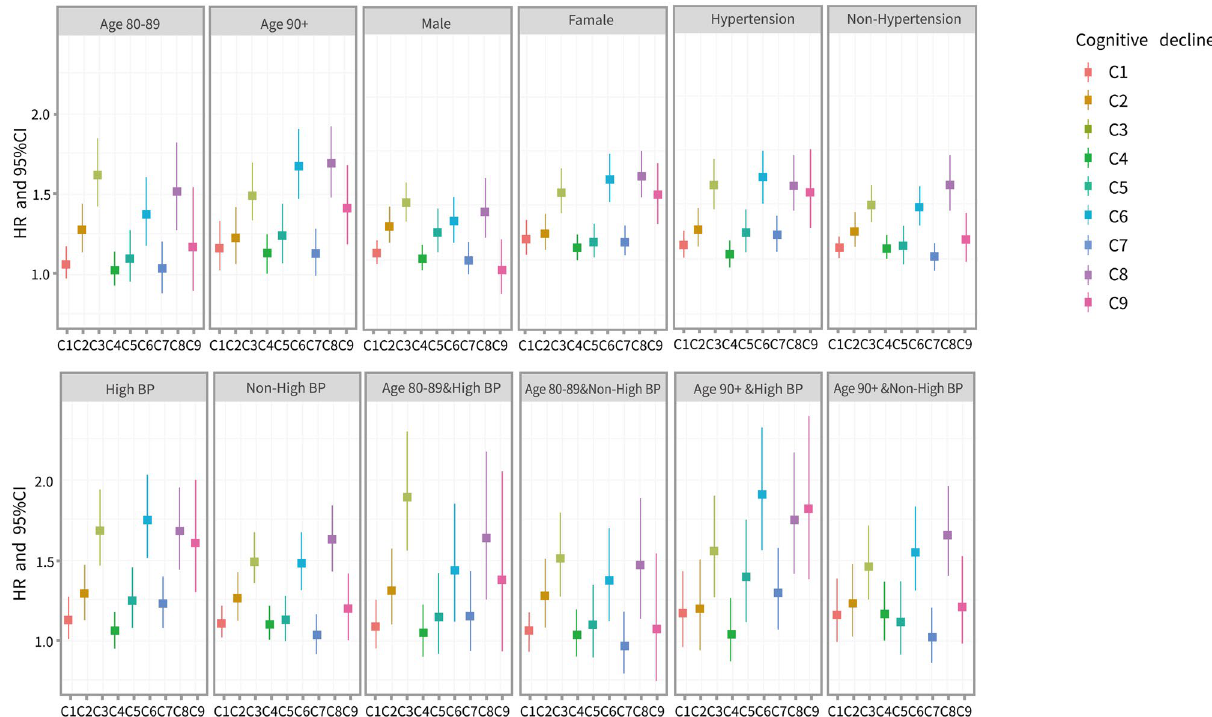
Figure 1. Potential effect modifiers of the association of cognitive decline, stratified into ten categories, with mortality after full adjustment for covariates. Adjustments for demographic characteristics (sex and age), socioeconomic status (residence, educational background, current spouse status, and living pattern), lifestyle factors (regular exercise, current smoking, current alcohol consumption, dietary diversity (DD)), leisure activities (housework, reading, watching TV or listening to the radio, keeping a pet and gardening) and health conditions (high blood pressure (BP), disability in activities of daily living (ADL), hypertension, and respiratory disease). Cognitive decline: Ten categories (C0–C9, compared to C0): C0 High normal cognitive function maintenance, C1 High normal cognitive function decline to low normal cognitive function, C2 High normal cognitive function decline to mild cognitive impairment, C3 High normal cognitive function decline to severe cognitive impairment, C4 Low normal cognitive function, maintain function, C5 Low normal cognitive function decline to mild cognitive impairment, C6 Low normal cognitive function decline to severe cognitive impairment, C7 Mild cognitive impairment maintenance, C8 Mild cognitive impairment maintenance, C9 Severe cognitive impairment